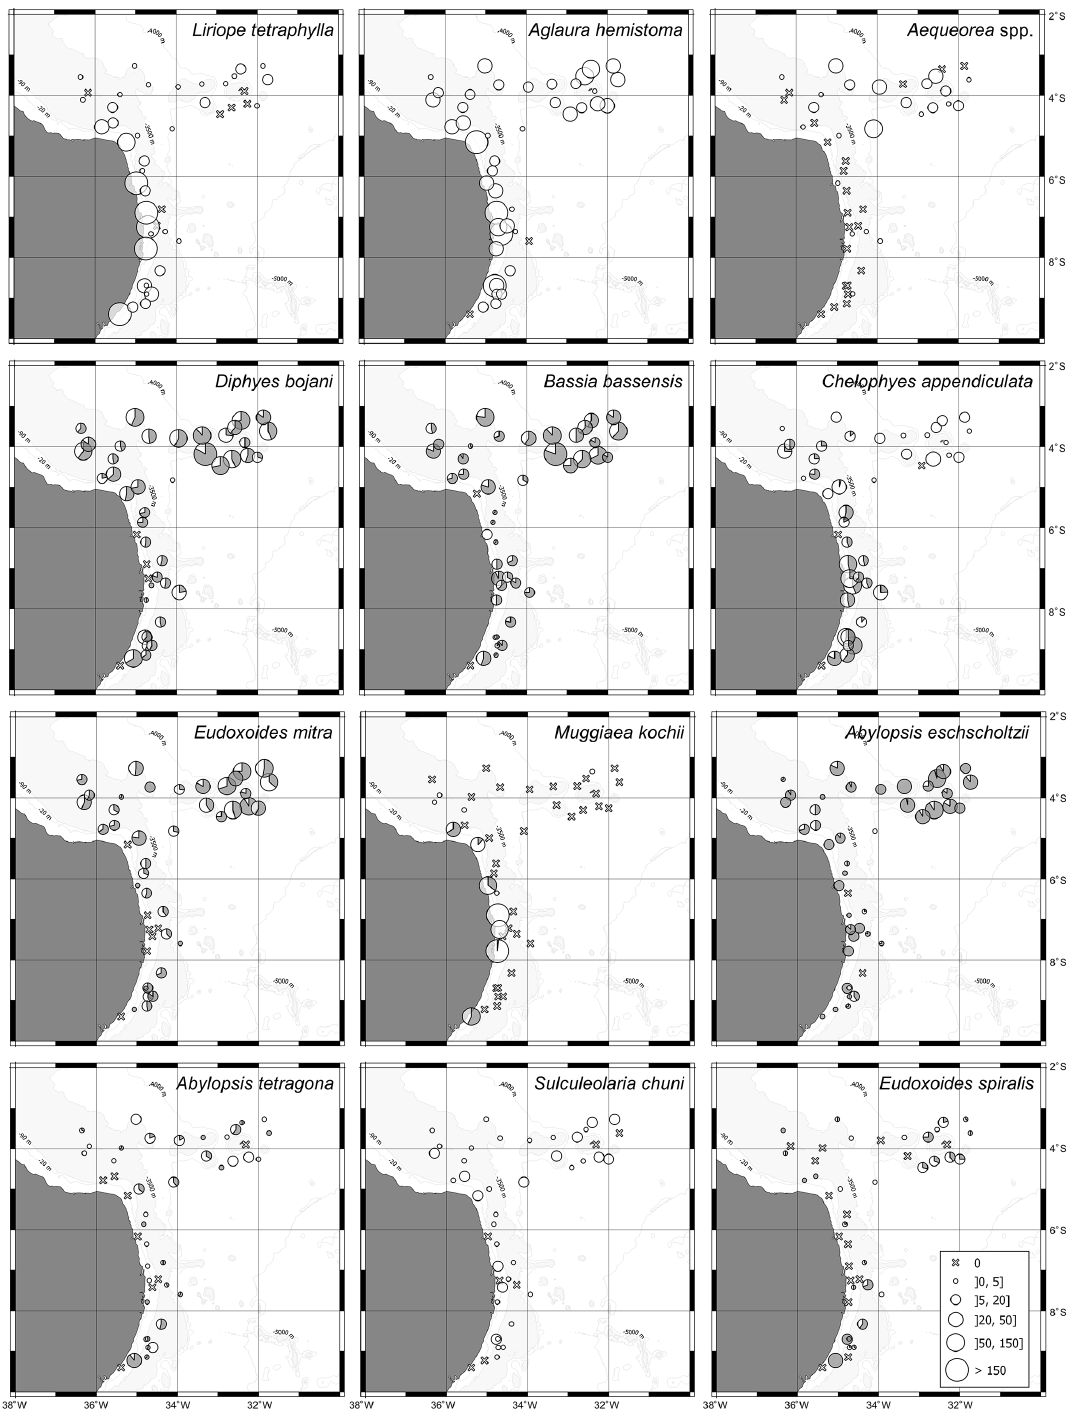
Figure 6. Geographic distribution of representative species of hydromedusae and siphonophores in the first 200m of the water column in autumn 2017. For calycophoran siphonophores, black represents the polygastric stage and white the eudoxid